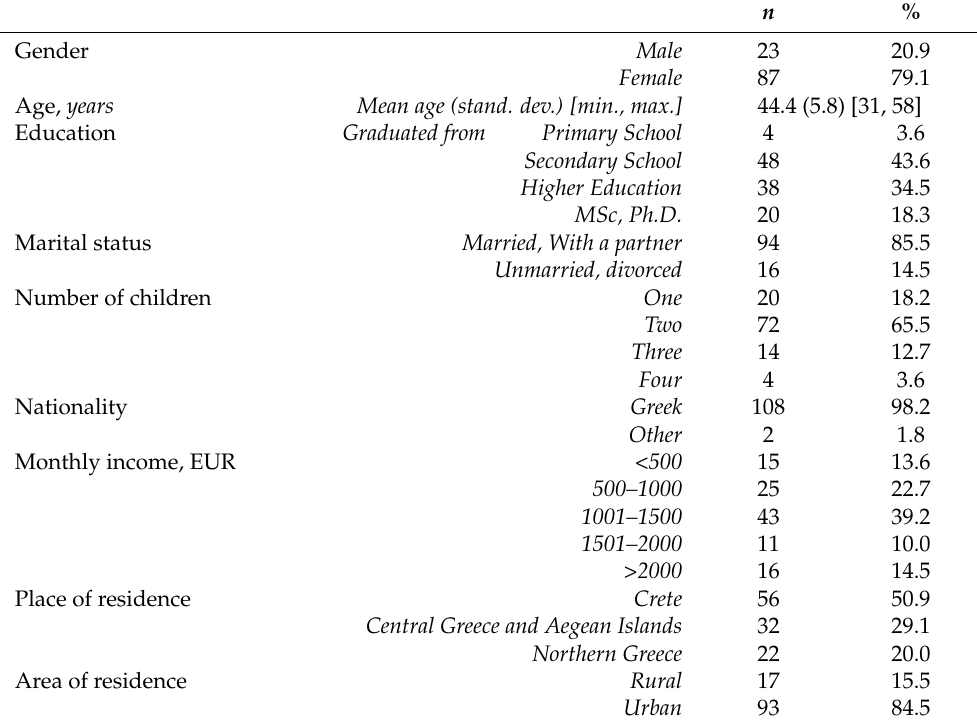
Table 1. General characteristics of 110 participating parents of children with DM1.